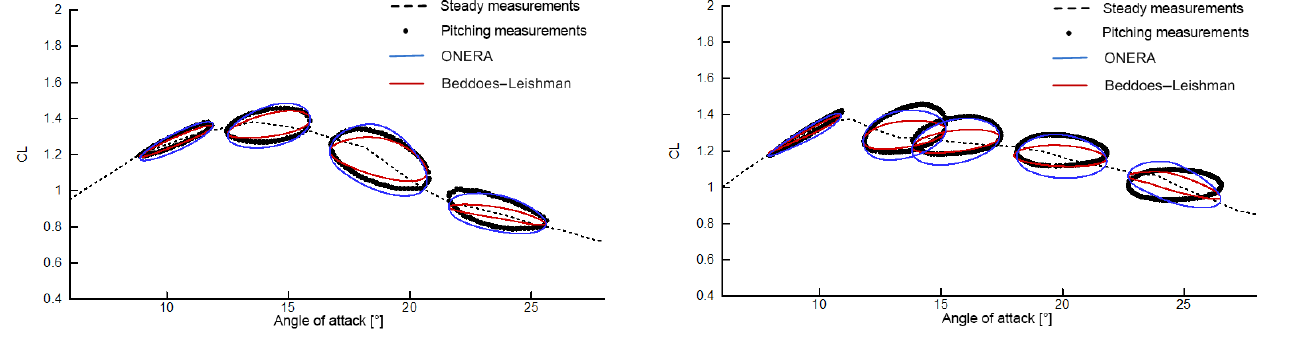
Figure 10. Comparison of engineering dynamic stall models against measurements. Results for a pitching NACA 63415. Mean angles of the four cases α 0 = 10 . 4 0 , 14 . 2 0 , 18 . 7 0 , 23 . 6 0 ; ampli- tudes of the four cases α 1 = 1 . 5 0 , 1 . 7 0 , 2 0 , 2 0 ; reduced frequency k = 0 . 09 (Bak et al., 2000).